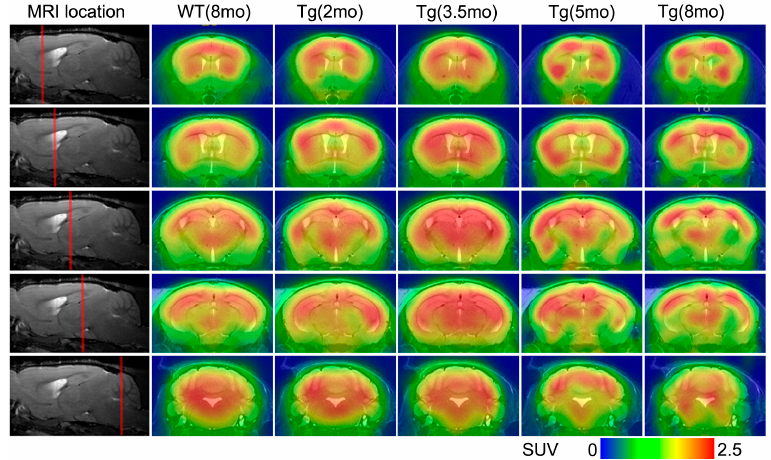
Figure 3. Results of PET/MRI fusion. Typical coronal 18 F-FDG-PET images from WT (8 mo) and Tg mice (2, 3.5, 5 and 8 mo), projected on standard T2-weighed MR images from a WT mouse. mo: month-old.